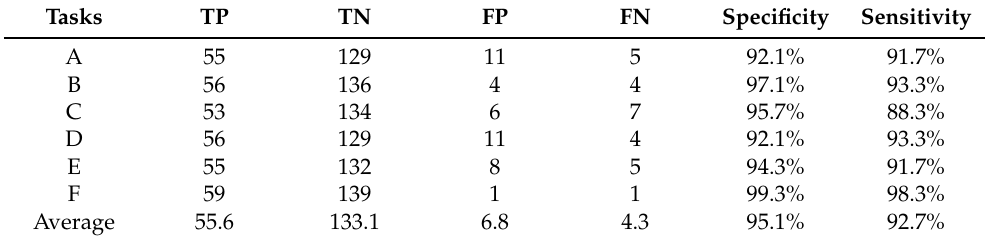
Table 4. The specificity and sensitivity of